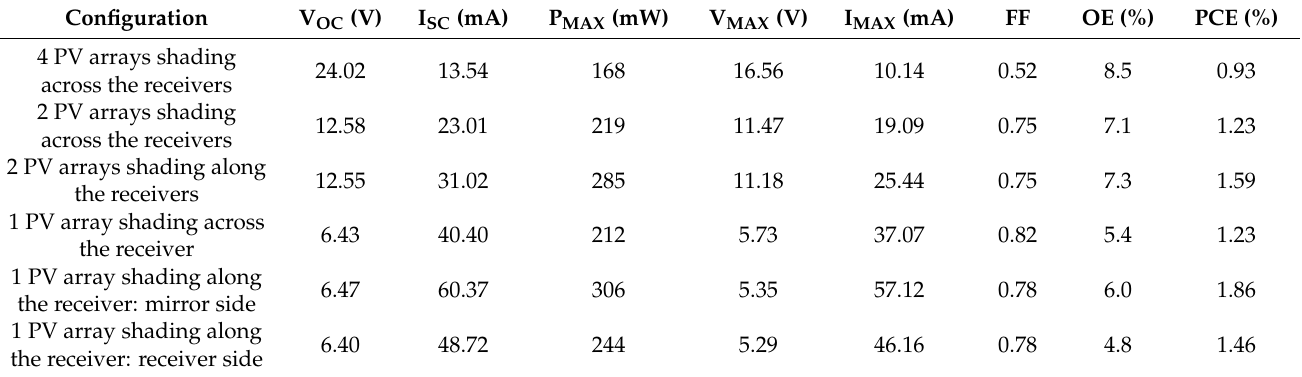
Table 2. Electrical performance of shaded LSC panels under a GNI equal to 630 W/m 2 .